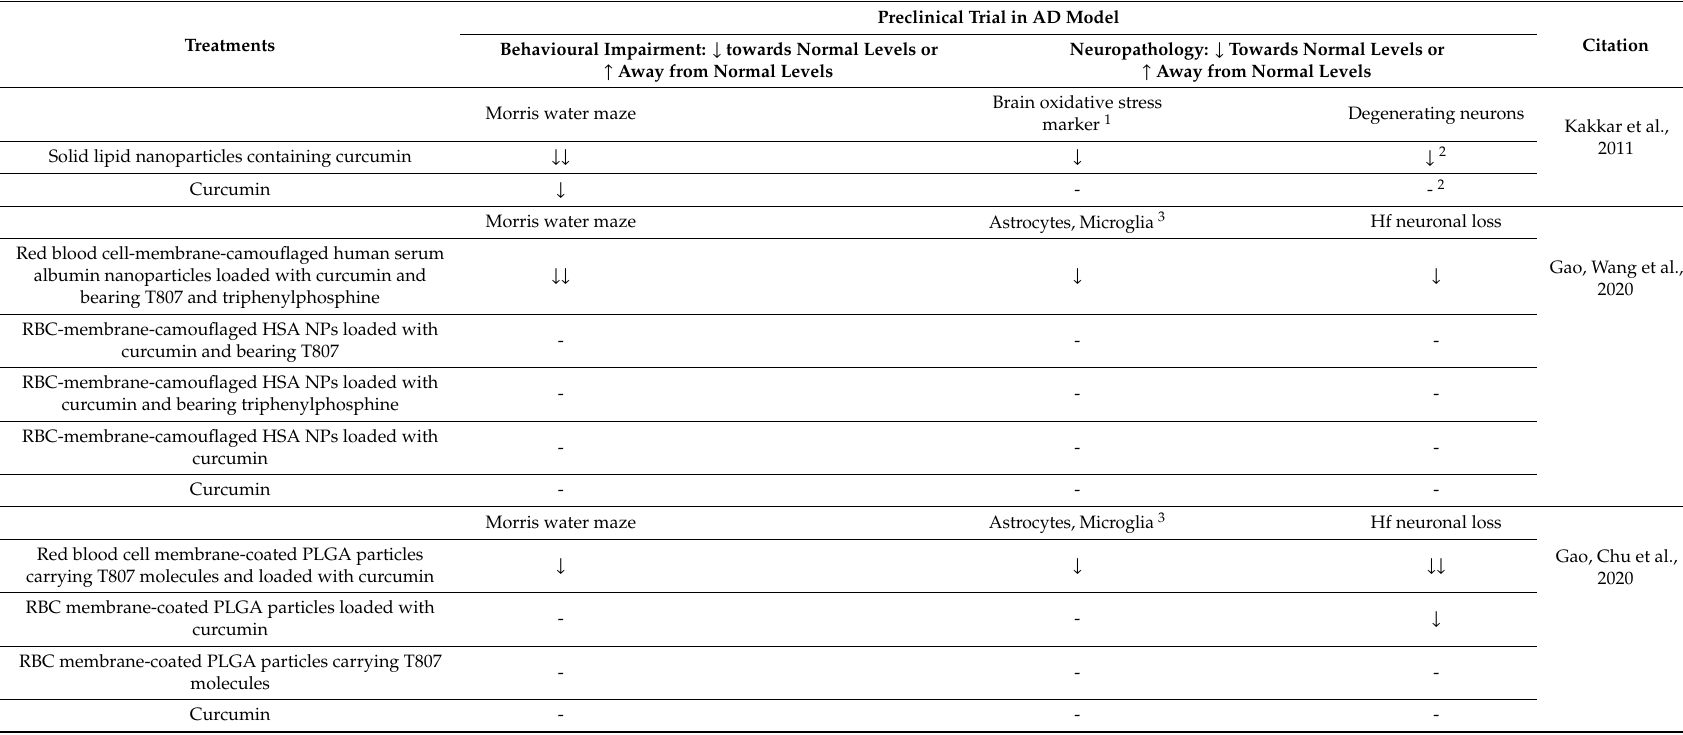
Table 2. Summary of available studies on NP curcumin in animal models of AD examining both cognitive behavior and pathology. ↑ and ↓ arrows are used to show whether outcome measure tended towards control (normal) levels or away from control (normal) levels and are relative. -, no e ff ect. Blank = not